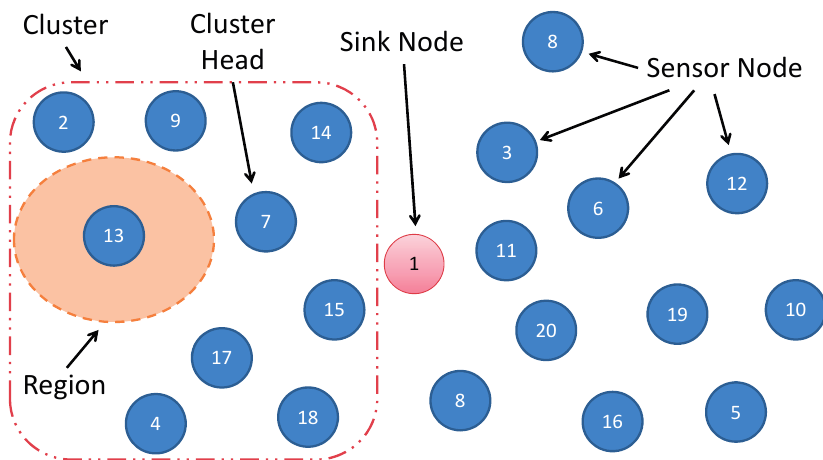
Figure 12. WSN region